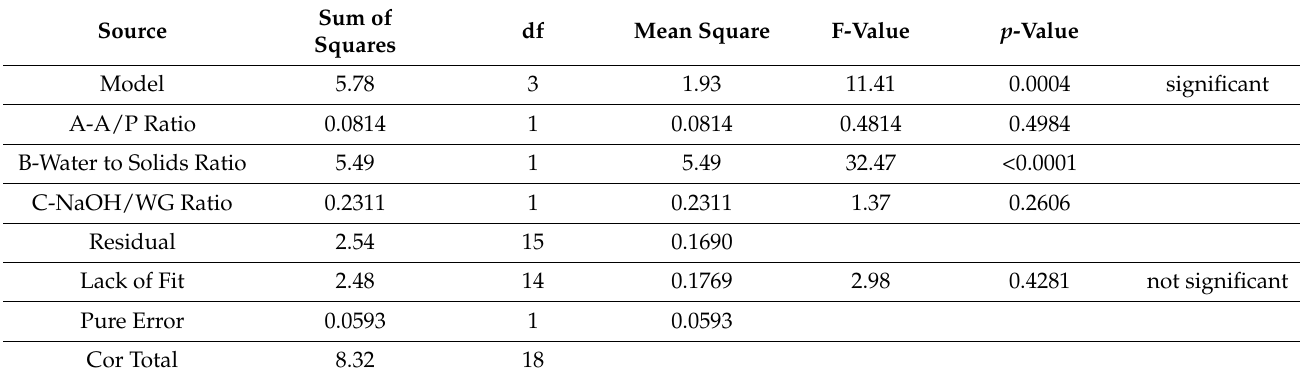
Table 11. ANOVA for linear model (Response 3: compressive